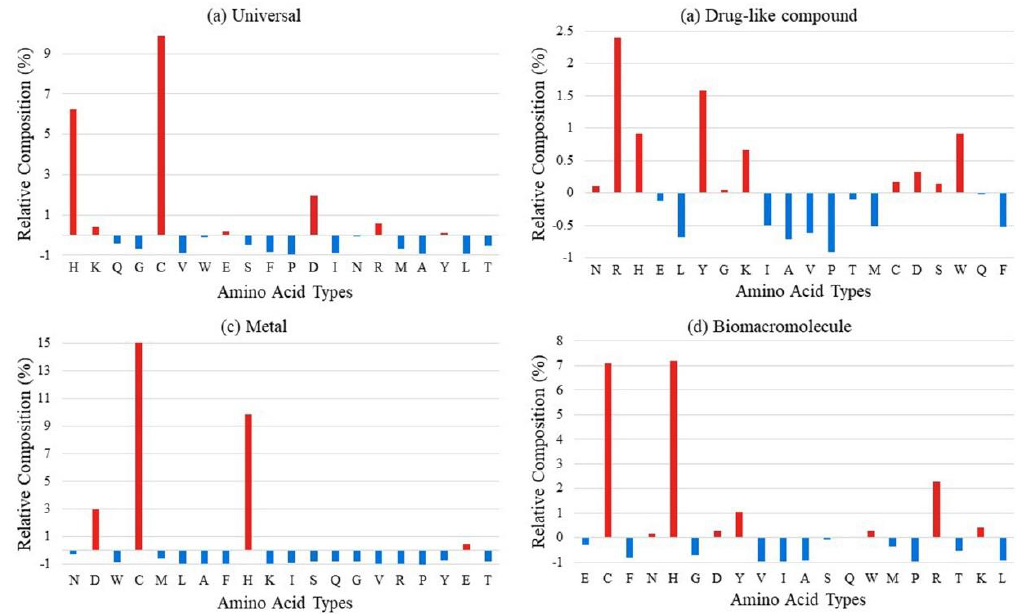
Figure 1. The relative composition of ( a ) universal ligand-binding residues, ( b ) drug-like compound- binding residues, ( c ) metal-binding residues, and ( d ) biomacromolecule-binding residues based on background distribution of all residues in corresponding datasets.